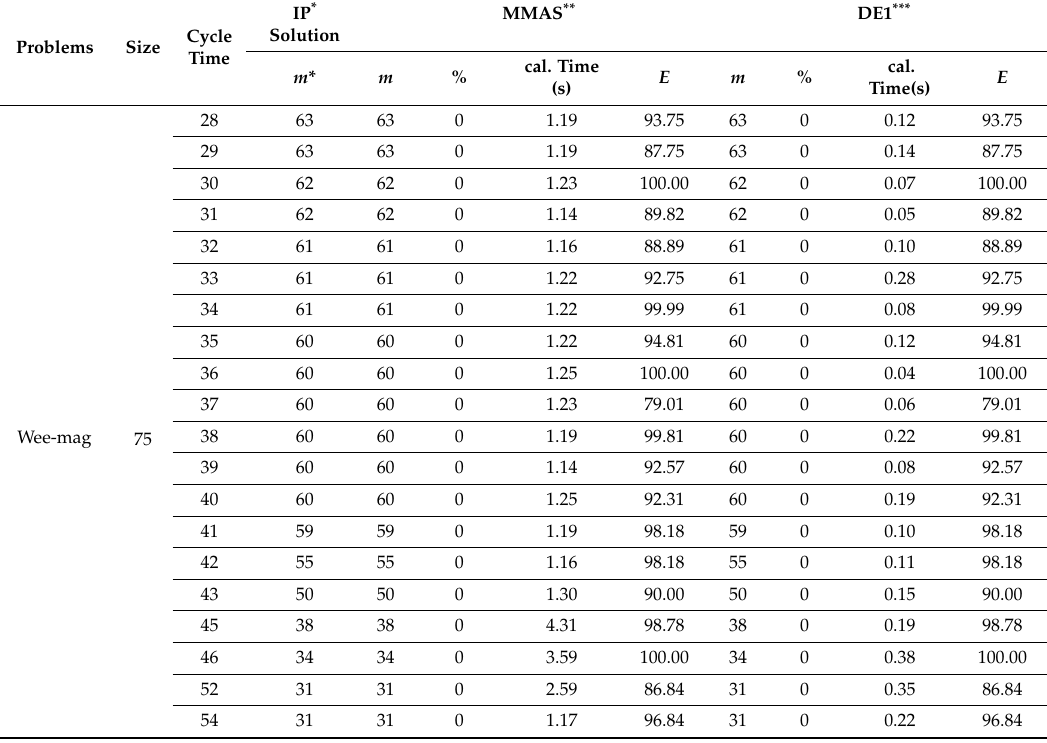
Table 7. The Results of Using the Proposed DE Compared to Using MMAS (No Local Search) [36]